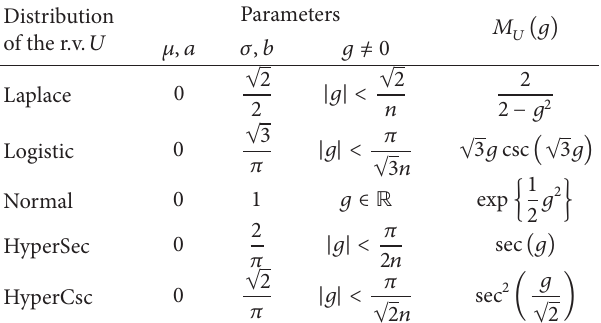
Table 2: Parameters of the pdf and moment generating functions of the random variable 𝑈